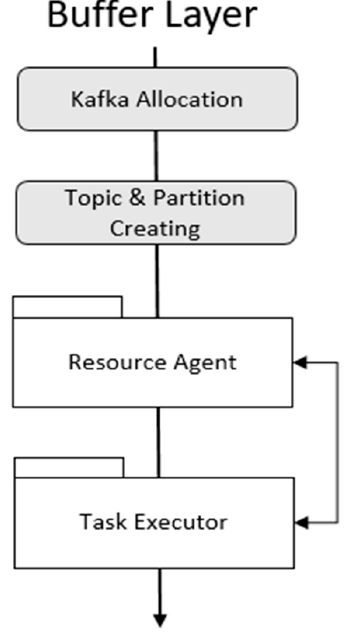
Figure 7. Module operation process on Buffer Layer.